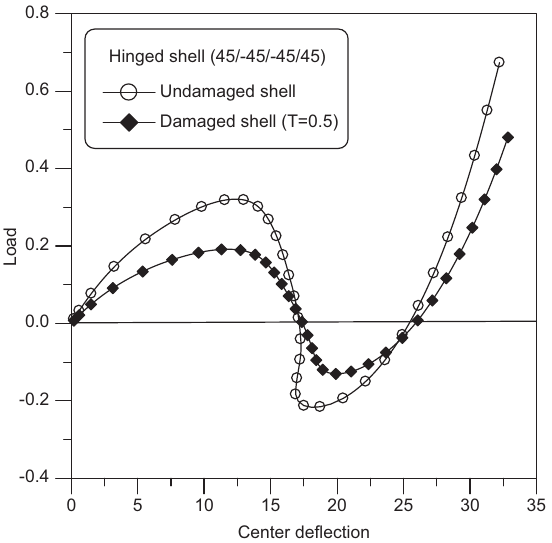
Figure 21 Load-displacement curves of hinged cylindrical shell.